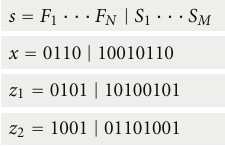
Figure 6: Proximity in solution